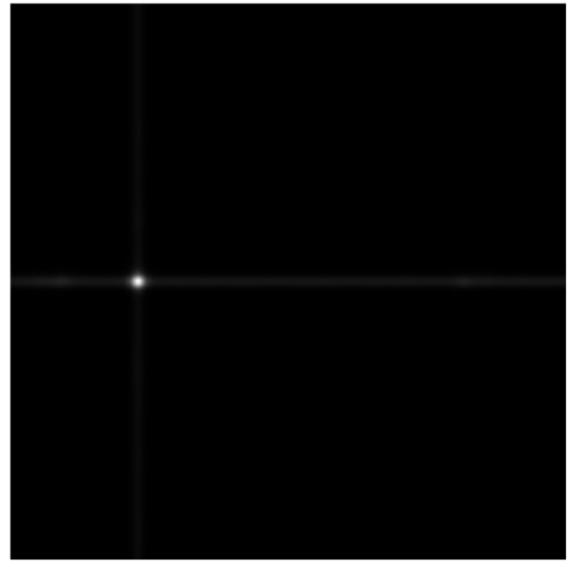
Figure 18. Improved results of slit scanning